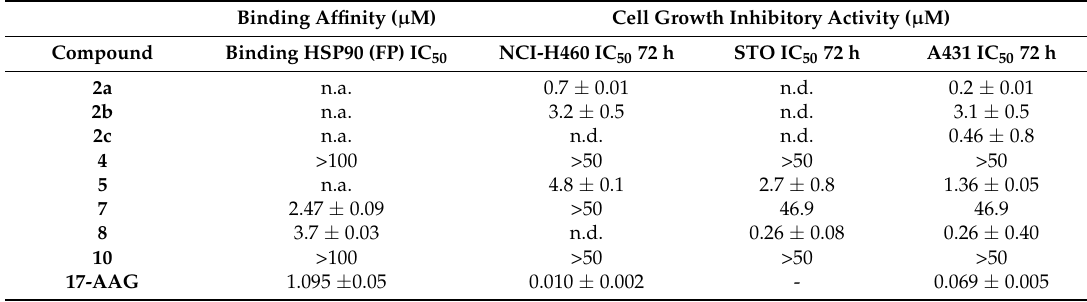
Table 1. Binding affinity ( µ M) to heat shock protein 90 (HSP90) protein and cell growth inhibitory activity ( µ M) of the compounds.